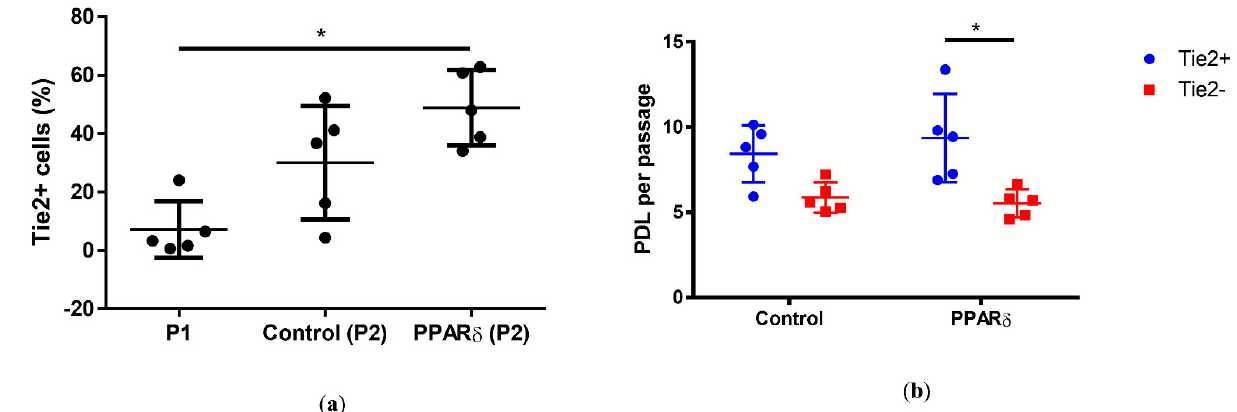
Figure 3. Plot of individual values of percentage of Tie2+ cells in the human NPC population ( a ), and population doubling level (PDL) of Tie2+ NPCs and Tie2- NPCs ( b ). Here, “P1” refers to the cells before seeding, “Control” represents cells cultured in control media without PPAR δ agonist, “PPAR δ ” refers to cells cultured with PPAR δ agonist treatment, “Tie2+” represents the NPCs that were stained positive to Tie2, and “Tie2+” represents the NPCs negative to Tie2; n = 5 ( a , b ), Kruskal – Wallis signed-rank (K – W) test with Dunn’s multiple comparison test; p = 0.0112 ( a ), 0.0327 ( b ); * = p -value < 0.05. Lines in (a – d) represent means ± standard deviation (SD).